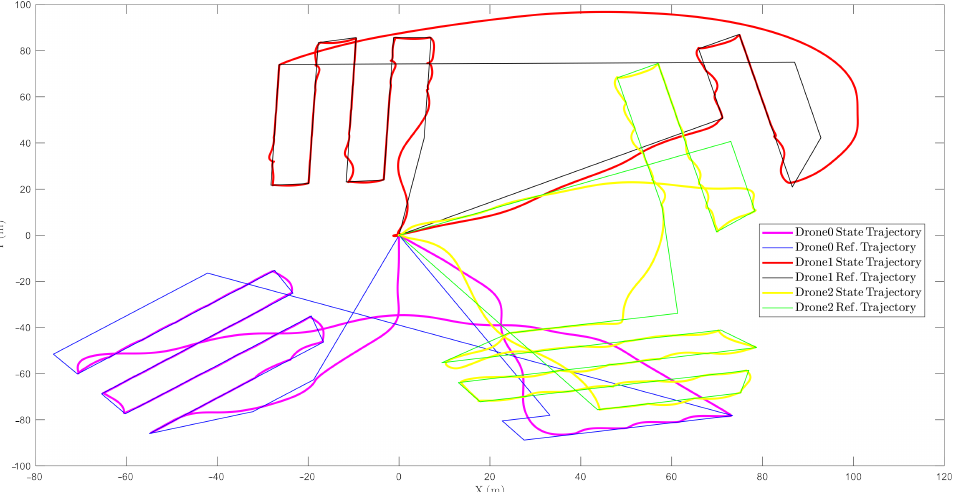
Figure 11. The simulation diagram of three drones in a swarm application.